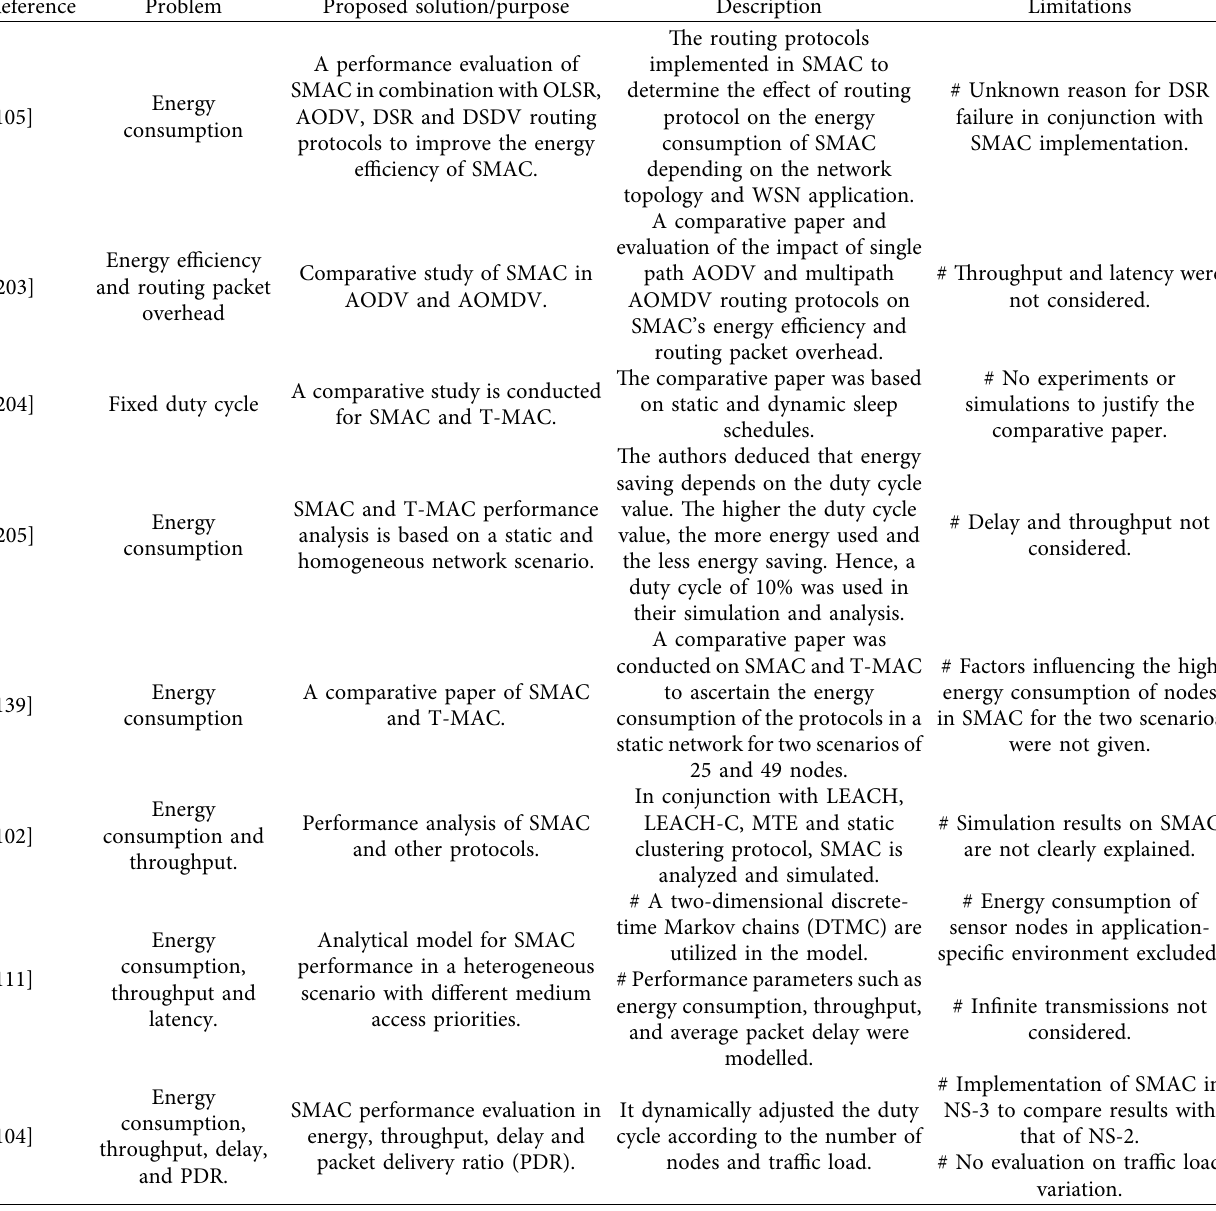
Table 11: Analytical modelling and comparative studies of